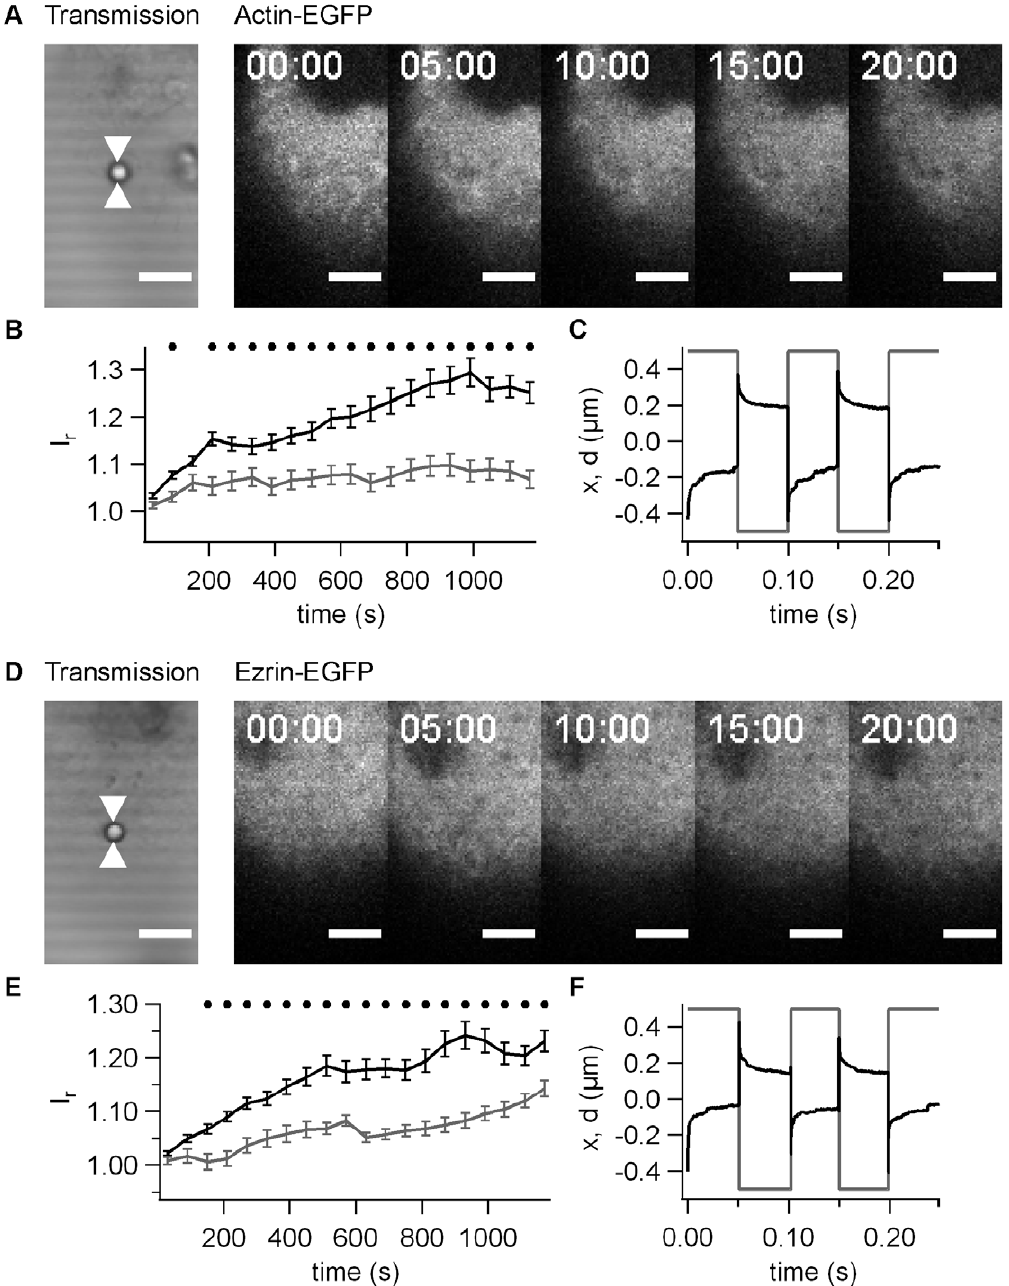
Figure 5. Accumulation of actin-EGFP and ezrin-EGFP depends on T4P. A) Typical time lapse for actin-EGFP for beads coated with pilE- preparation (no pili). B) Relative fluorescence intensity I r as a function of time for actin-EGFP averaged over 15 beads. Black line: T4P preparation from N400 wt pili, grey line: T4P preparation from pilE- strain. C) Grey line: The laser focus was moved by x = 6 0.5 m m with respect to the initial position with a frequency of 10 Hz. Black line: Typical signal of the quadrant photodiode showing the position d . D) Typical time lapse for ezrin-EGFP for beads coated with pilE- preparation. E) Relative fluorescence intensity I r as a function of time for ezrin-EGFP averaged over 15 beads. Black line: T4P preparation from N400 wt pili, grey line: T4P preparation from pilE- strain. F) Grey line: The laser focus was moved by x = 6 0.5 m m with respect to the initial position with a frequency of 10 Hz. Black line: Typical signal of the quadrant photodiode showing the position d . B,D) Black dots mark statistical significant different values with pili and without pili (t-Test significance level p , 0.01).